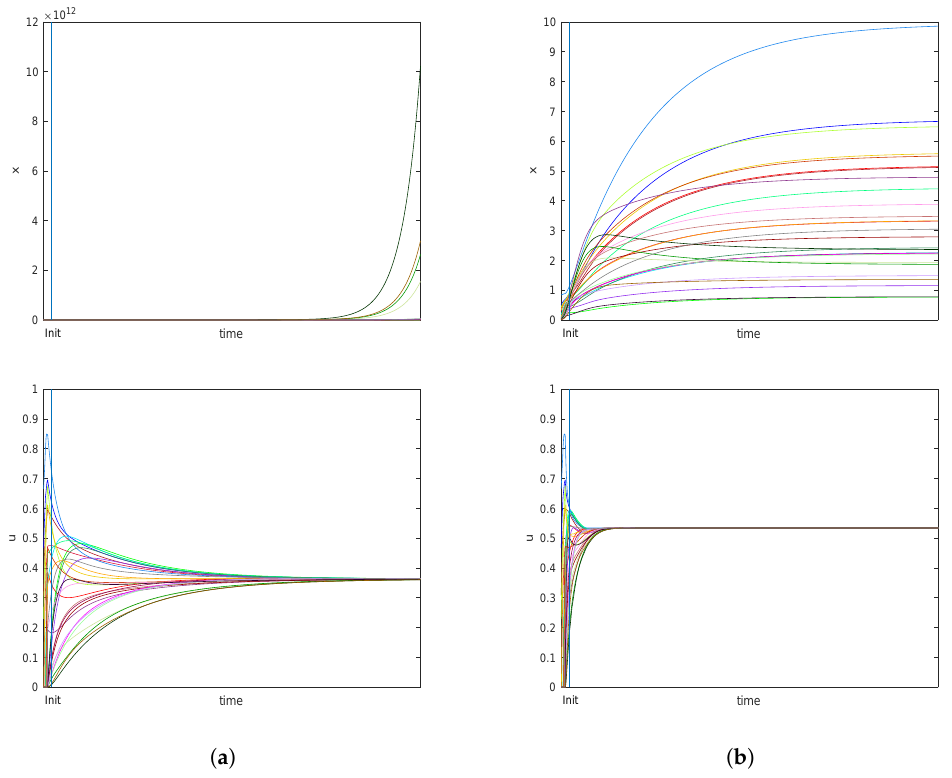
Figure 5. Pollution stock x and investment u into environmentally friendly policies for each player with both a basic and more advanced imitation behavior with a short initial phase in which all players minimize their individual costs. All results are obtained with the same initial conditions such as the initial values for x i ( 0 ) . ( a ) Basic imitation behavior after a short initial phase; ( b ) More advanced imitation behavior after a short initial